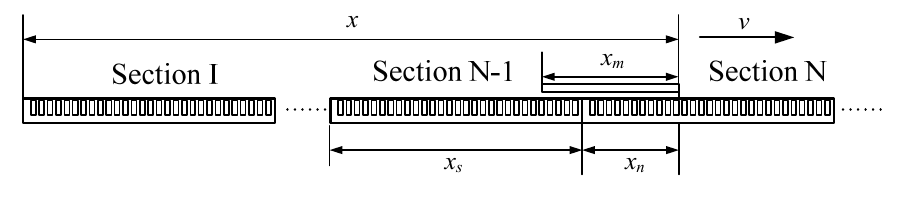
Figure 2. Structure of WS-PMLM.